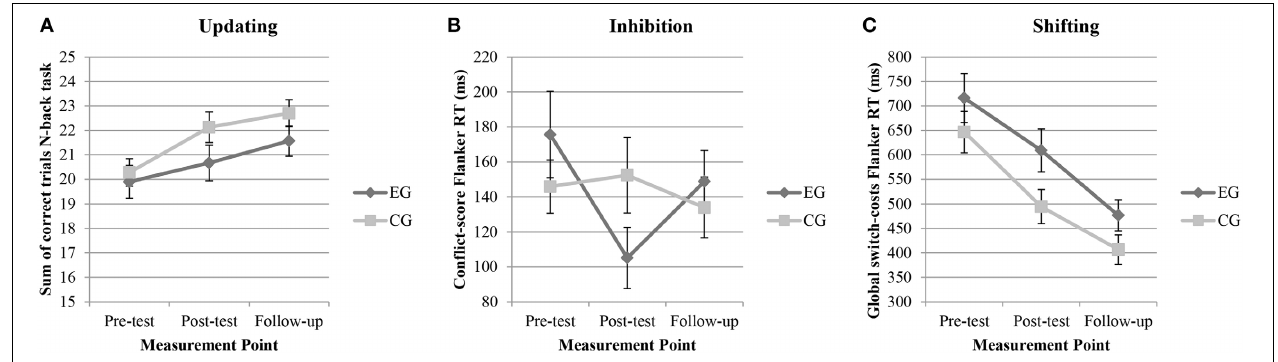
FIGURE 2 | Representation of means and error bars (representing standard error of the mean) for (A) updating, (B) inhibition, and (C) shifting over the three measurement points (pre-test, post-test, follow-up). CG , control group, EG , experimental group, RT , reaction